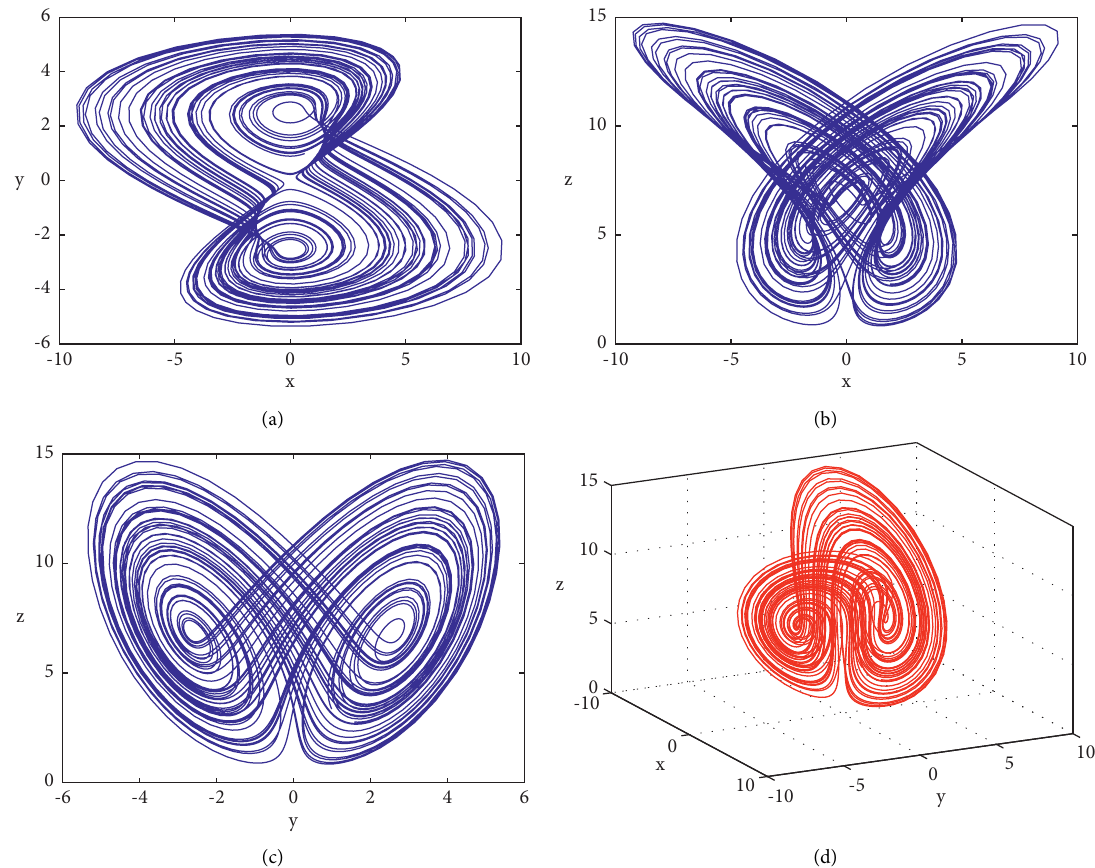
Figure 1: Phase portrait of the Rucklidge system in different two-dimensional (2D) and three-dimensional (3D) phase spaces for ( a, b ) � ( 2 , 6 . 7 ) from t � 20000 to 20300.